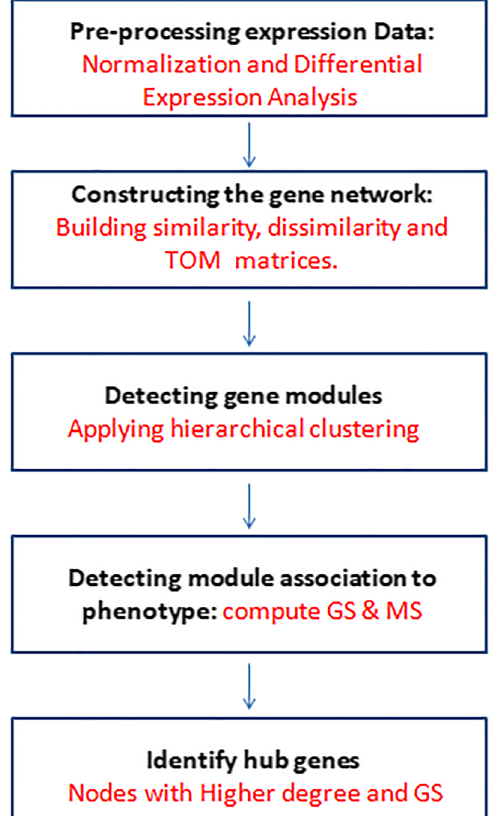
Figure 1: Network construction and module detection